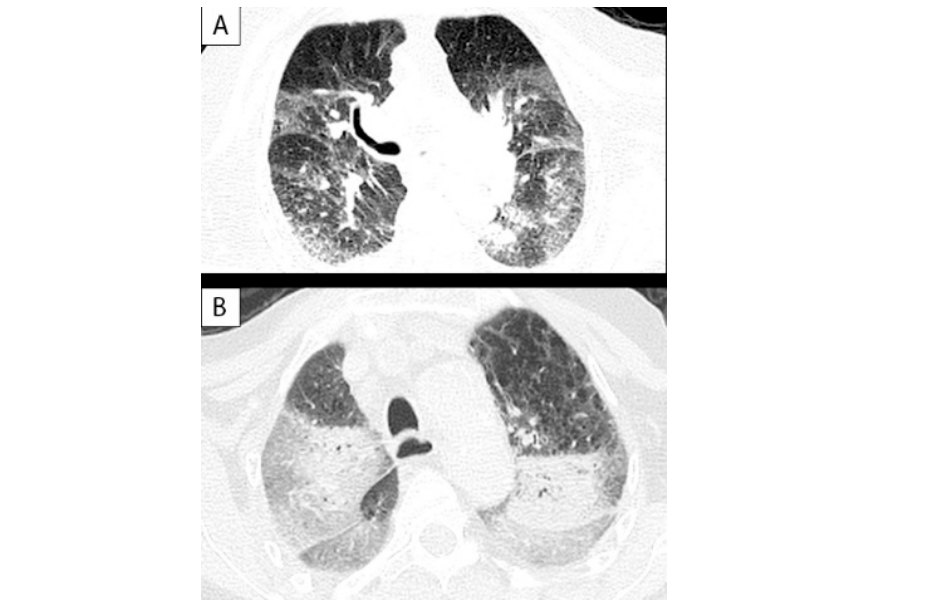
Figure 3. Post-mortem lung CT (parenchymal window) showing “ground glass” opacities in a subject of group A ( A ) and in one of group B ( B ). In A, the distribution of opacities was bilateral, peripheral, and without gravitational gradient. This pattern is considered typical in COVID-19 pulmonary infection. In B, the “ground glass” opacities showed a more central and gravitational distribution, as seen in post-mortem CT lung changes. Table 3. Post-mortem CT